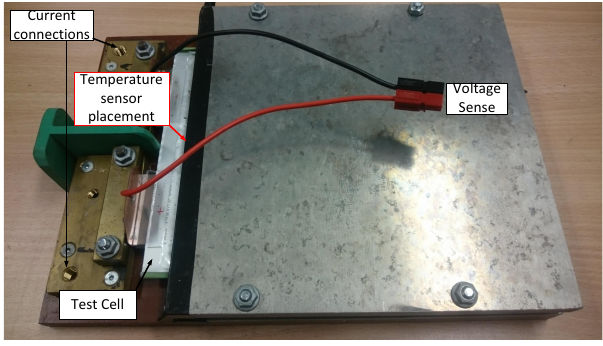
Figure 1. Test cell with holder.